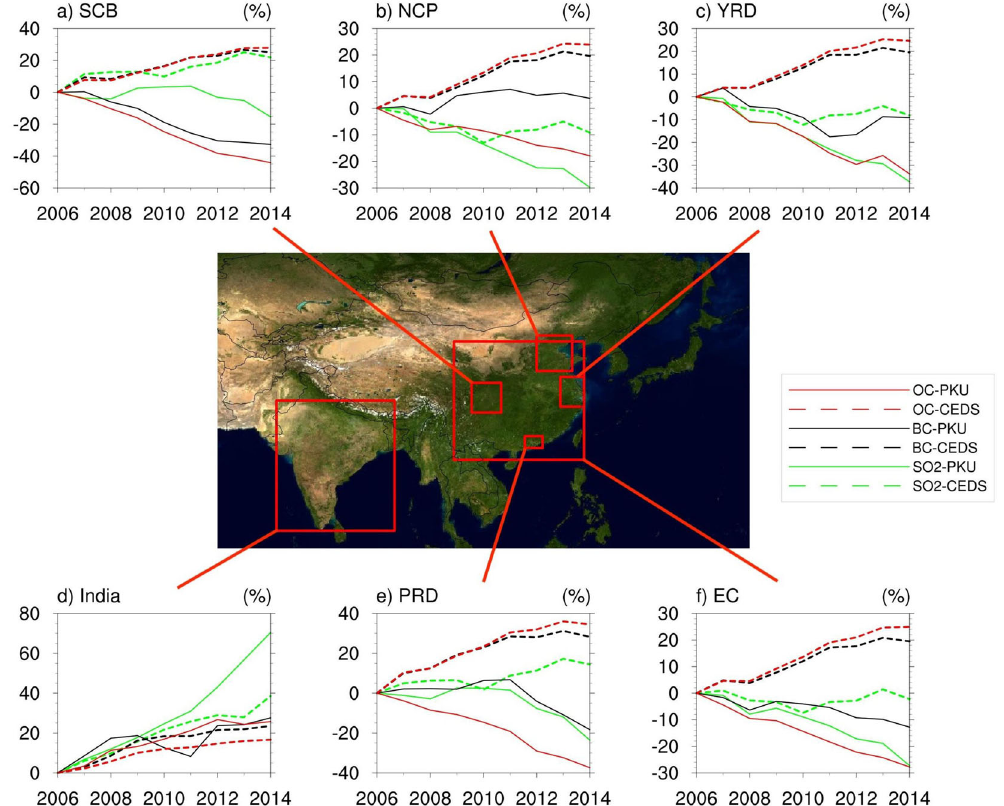
Fig. 2 Relative changes in annual anthropogenic aerosol emissions during 2006 – 2014. Changes in SO 2 (green), BC (black), and OC (red) emissions in key regions of a – e China and f India from CEDS (dashed line) and PKU (solid line) inventories, respectively (units: %). All values